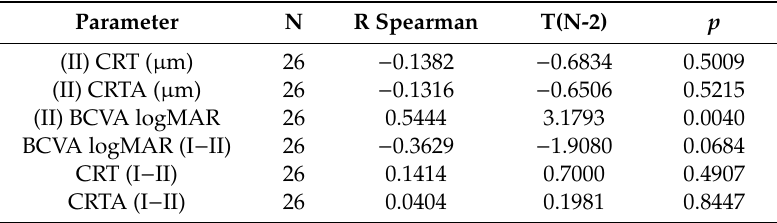
Table 6. Spearman correlation rank test for the relationship between the duration of CSCR and the parameters of retinal morphology and function after treatment in patients with a total resolution of SRF.